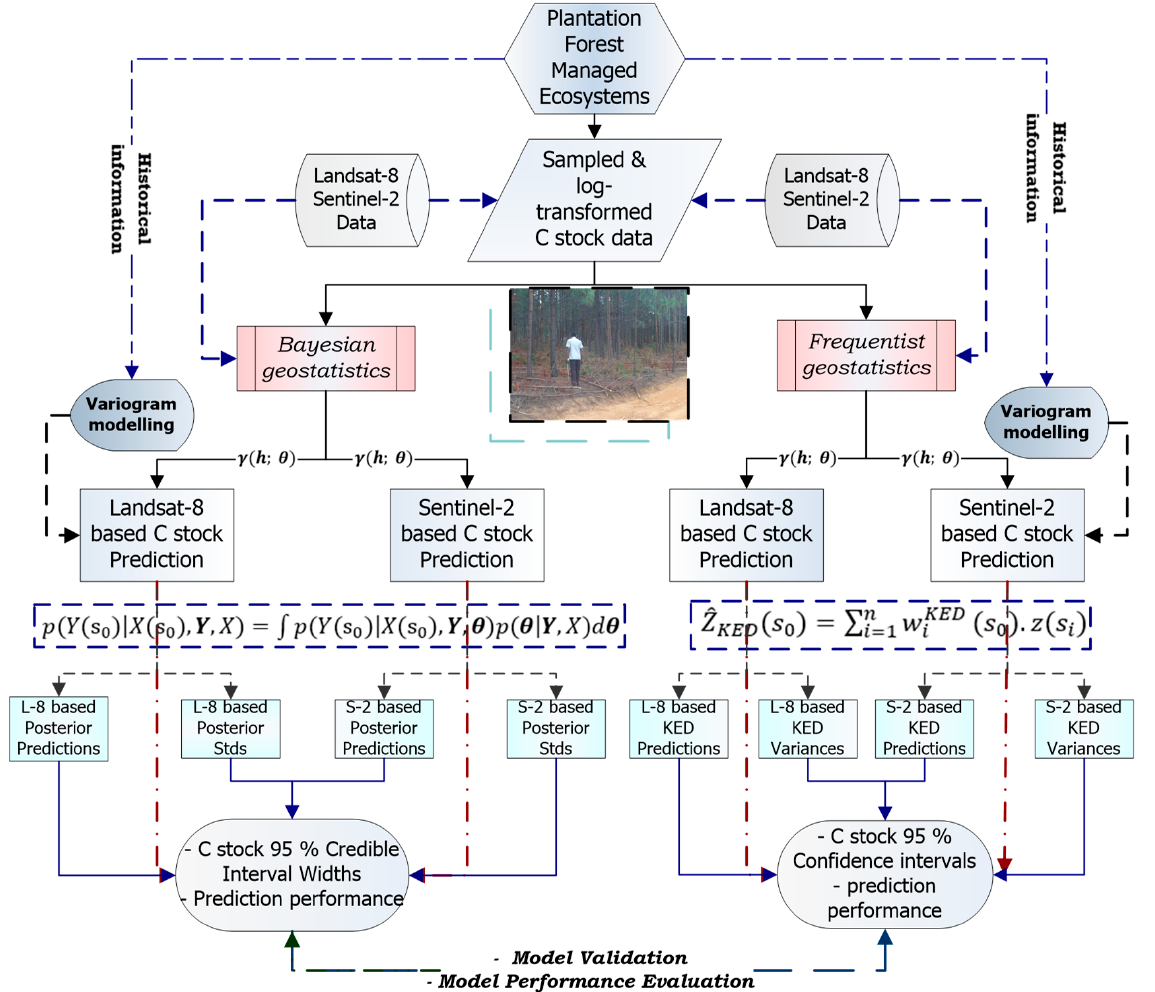
Figure 2. Bayesian and frequentist geostatistical modelling framework.